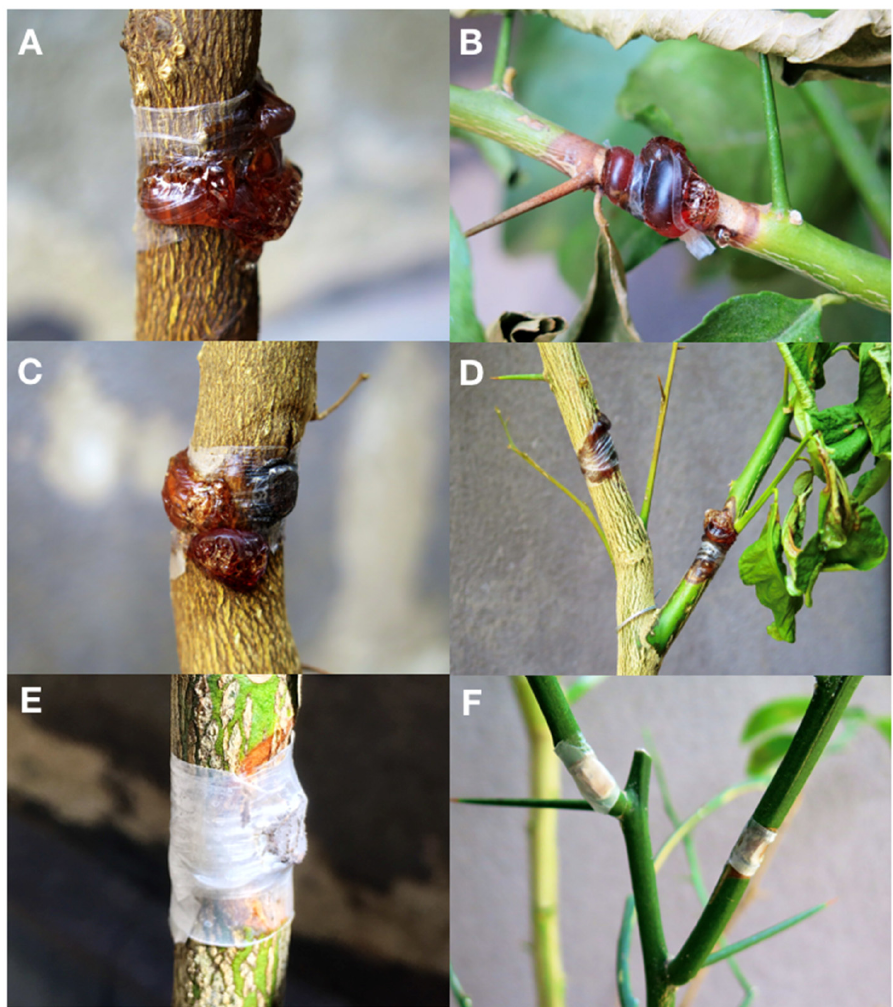
Figure 7. Gum exudate induced by wound-inoculation of Neofusicoccum parvum on stems and twigs of lemon ‘Femminello Siracusano 2kr’ ( A , B ) and ‘Monachello’ ( C , D ) 14 d a.i.; necrotic lesions without gummous flux on inoculated Citrange ‘Carrizo’ ( E , F ).